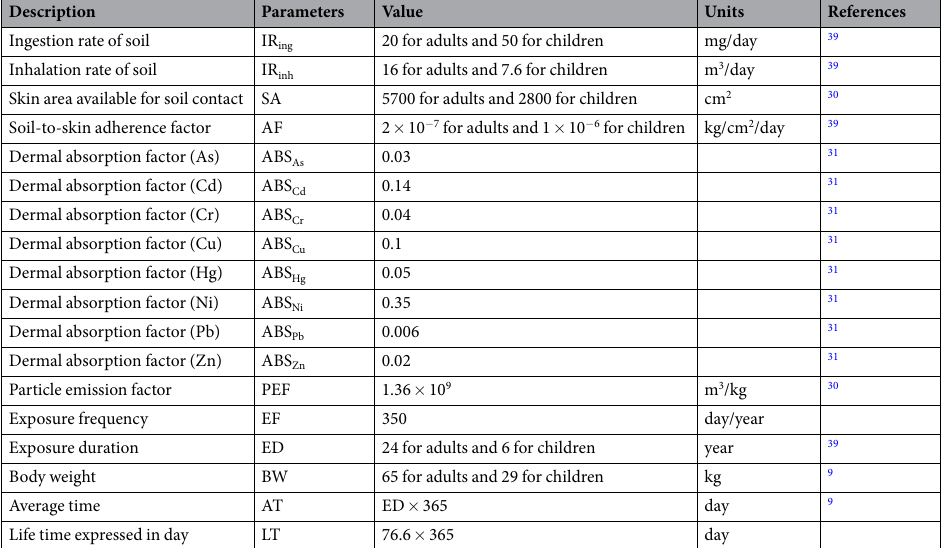
Table 4. Parameters for health risk assessment. * 0.001 for absorption factor (ABS) of all the HMs was also widely used